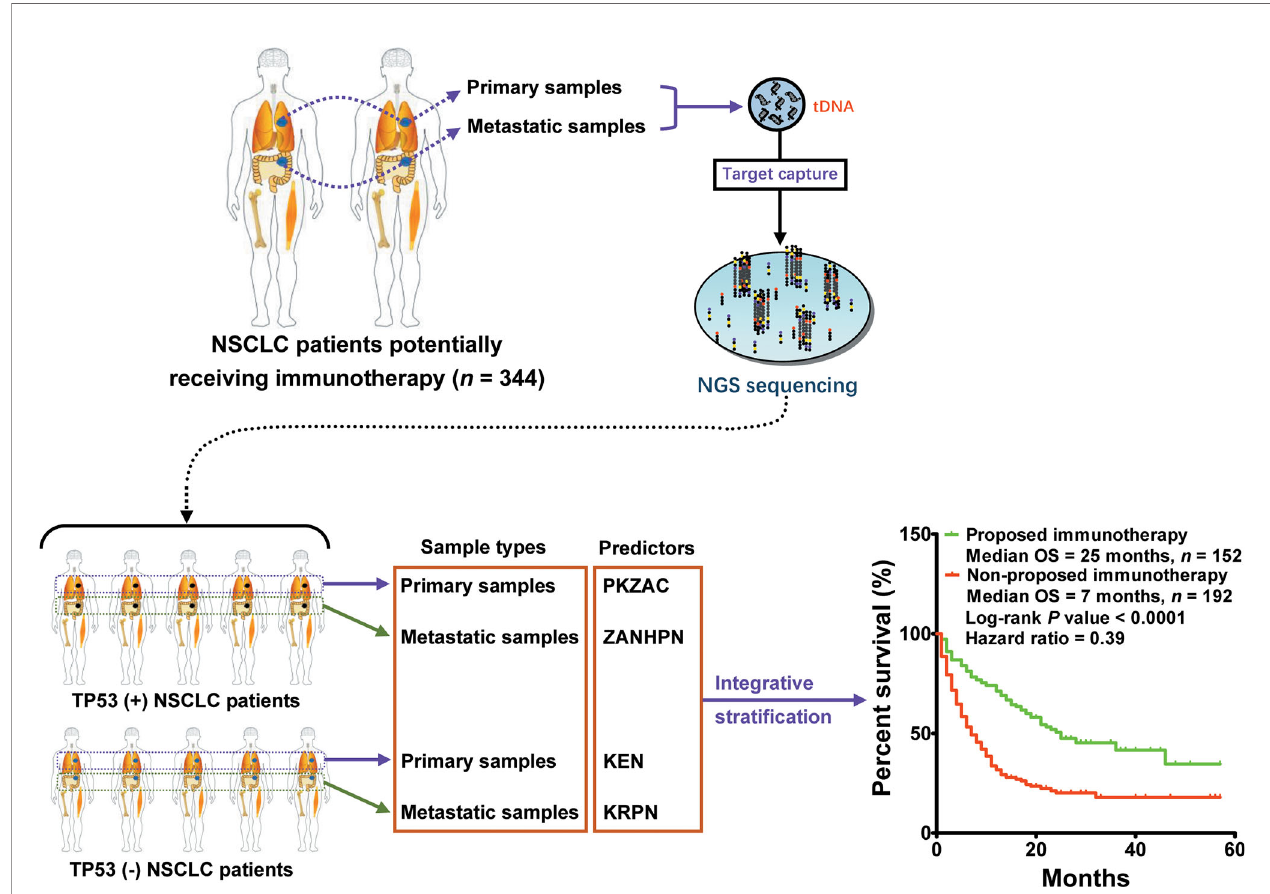
FIGURE 6 | Integrative strati fi cation using different TP53 mutation status and biopsy lesion types for immunotherapy in NSCLC. Samples from different lesions (metastatic and primary lesions) were subjected to standard high-throughput sequencing. The mutation pro fi le of each patient was used for driver gene-based subtype analysis. In total, 344 patients with NSCLC were divided into two cohorts: [ TP53 (+) cohort and TP53 ( − ) cohort]. According to biopsy lesion type, NSCLC patients were further divided into TP53 (+) metastatic sample cohort, TP53 (+) primary sample cohort, TP53 ( − ) metastatic sample cohort, and TP53 ( − ) primary sample cohort. Each cohort developed an independent optimal predictor. Patients who potentially received more OS bene fi ts from immunotherapy were screened by integrative strati fi